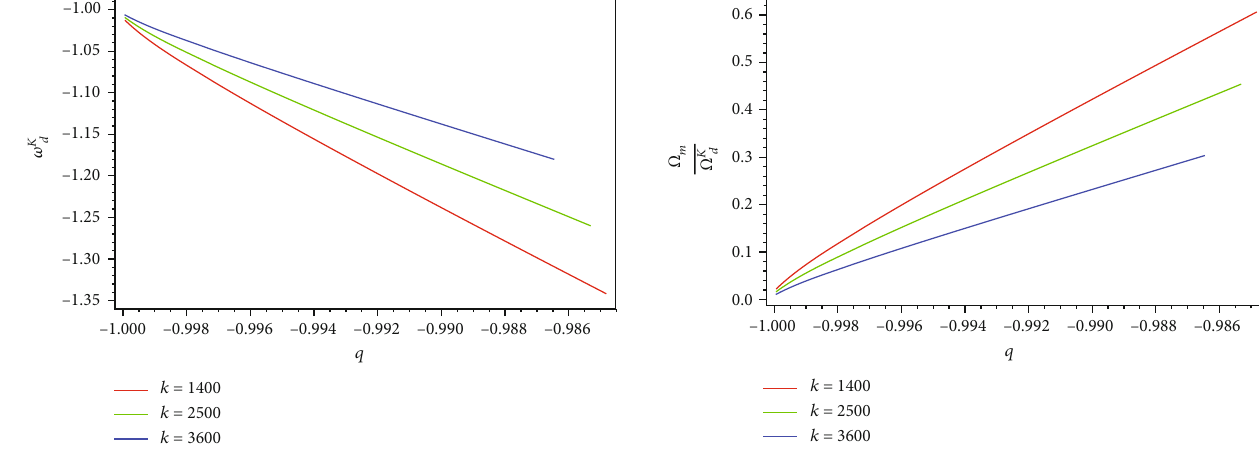
versus deceleration parameter q d